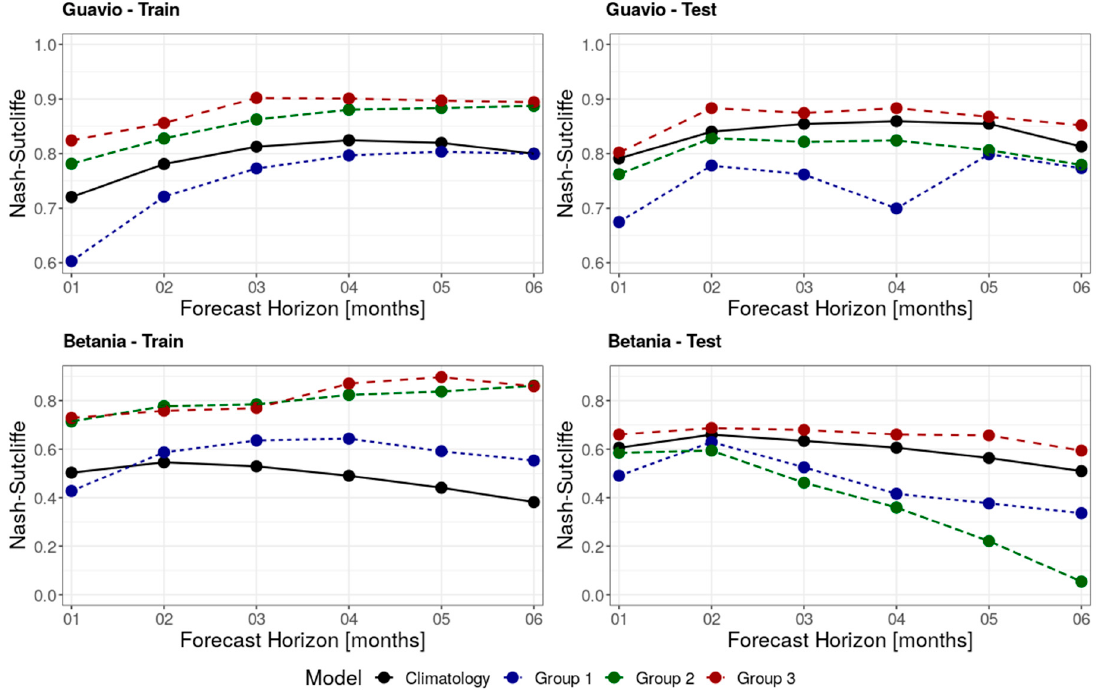
Figure 4. Nash–Sutcliffe results of the machine learning models and validation metrics per group.